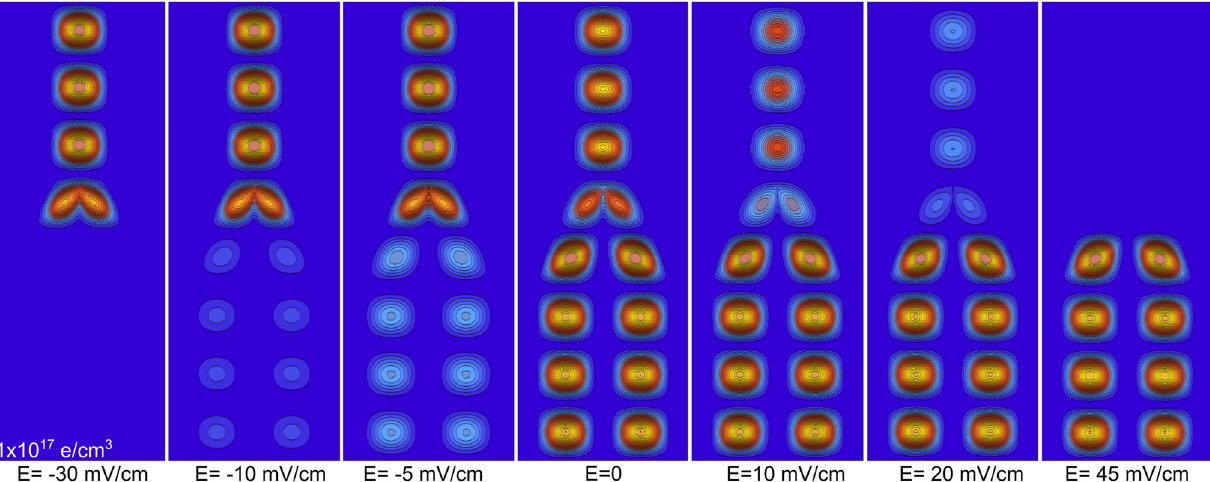
Figure 7. x – z projections of the charge distribution probability for the third-excited state of a Y-J of L x , y = 25 nm, L b = 10 nm, length L z = 2 µ m, and n =5 × 10 17 electrons/ cm 3 . The electric field magnitude applied along the z -axis is indicated in each figure. x and z scales are the same as the ones in Fig.